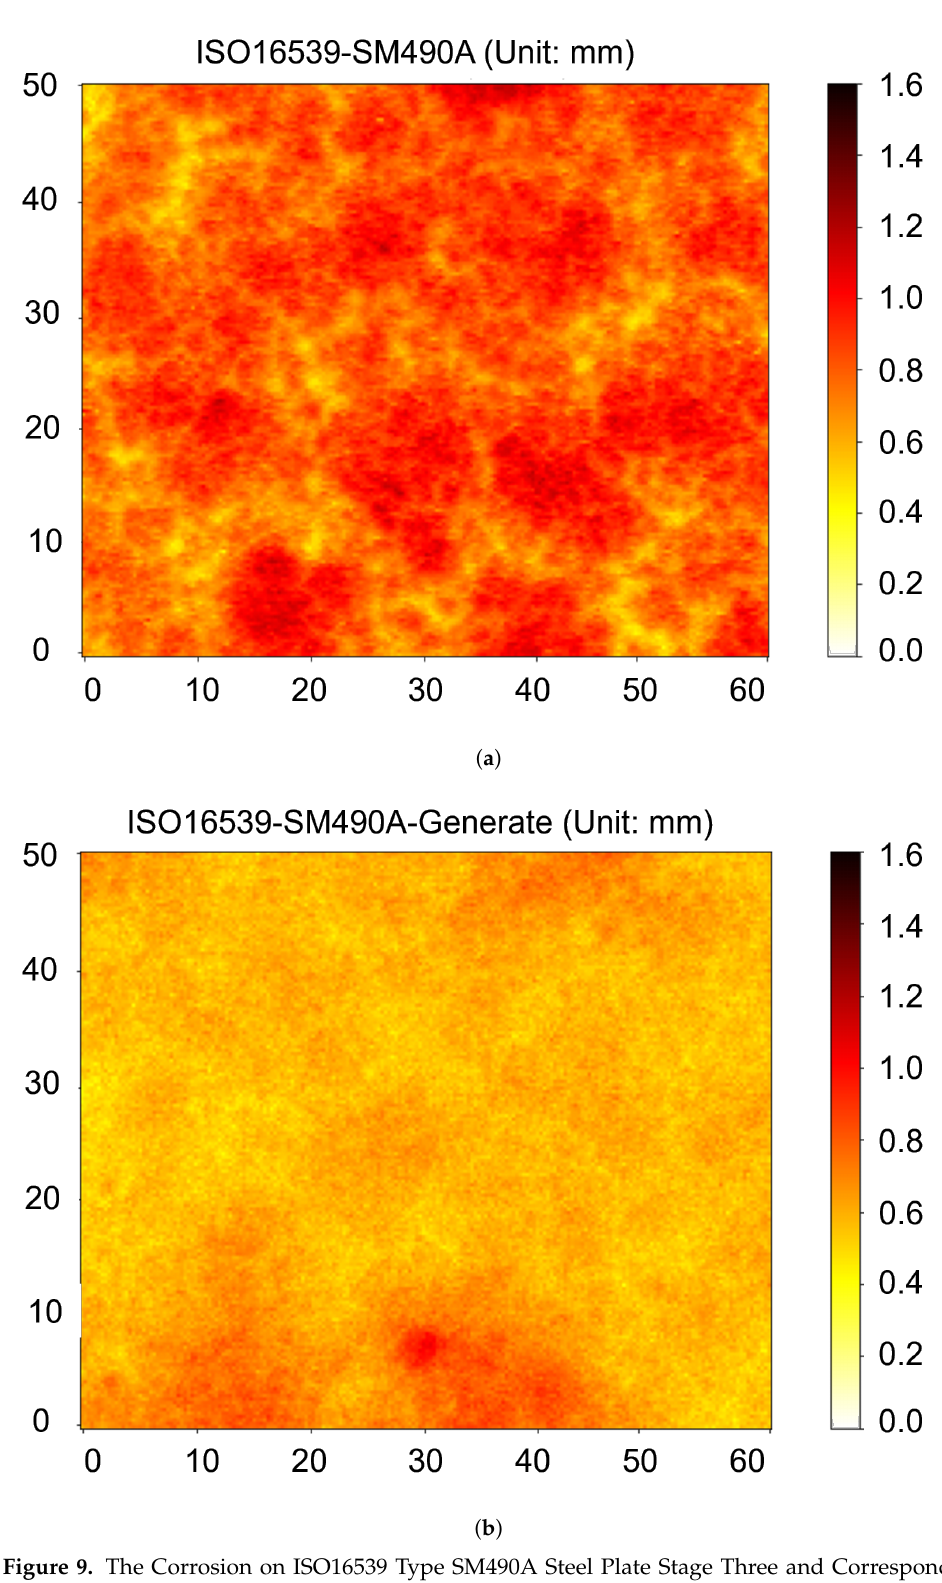
Figure 9. The Corrosion on ISO16539 Type SM490A Steel Plate Stage Three and Corresponding Simulated Corrosion; ( a ) The Corrosion on ISO16539 Type SM490A Steel Plate Stage Three; ( b ) The Corrosion on Simulated Type SM490A Steel Plate Stage